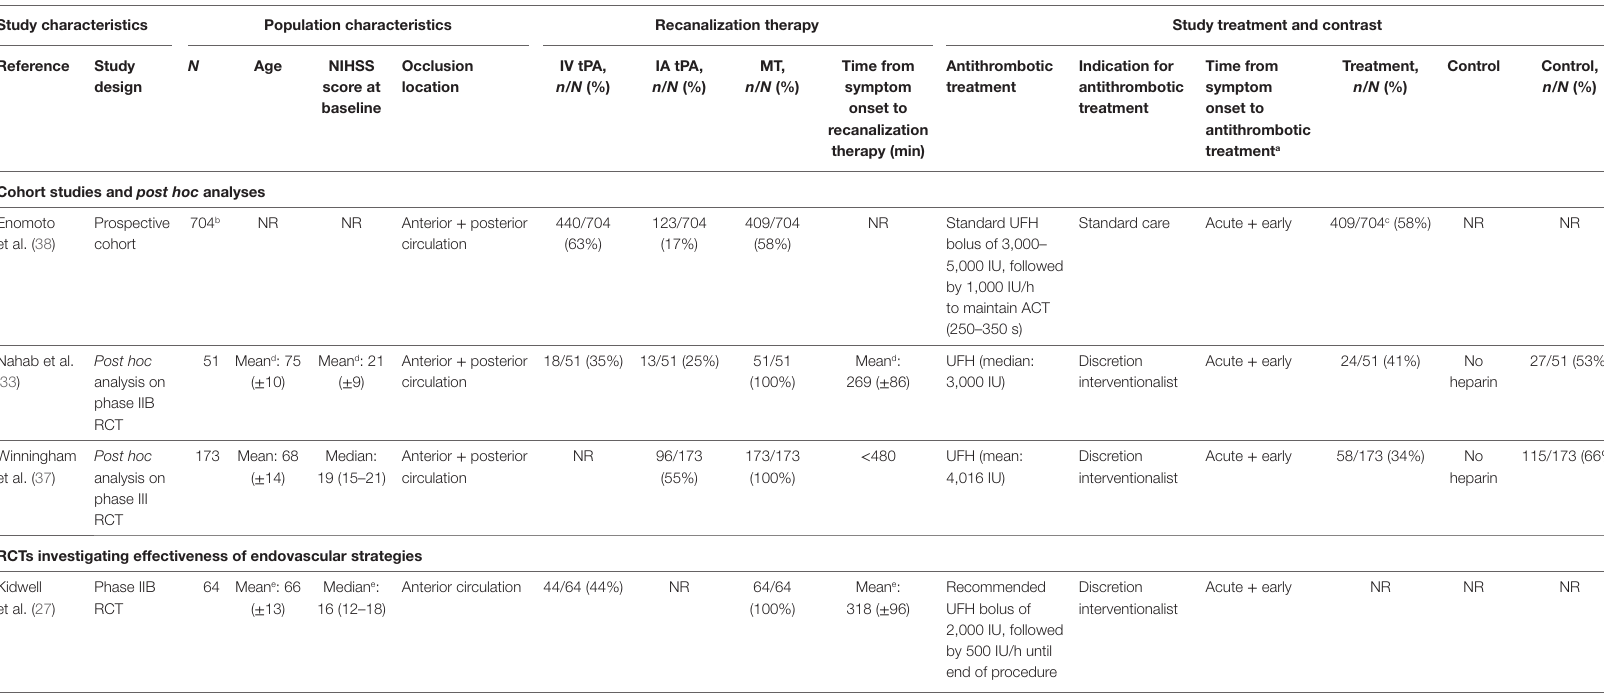
taBLe 5 | Characteristics of included studies investigating periprocedural heparin use in patients with ischemic stroke who underwent acute